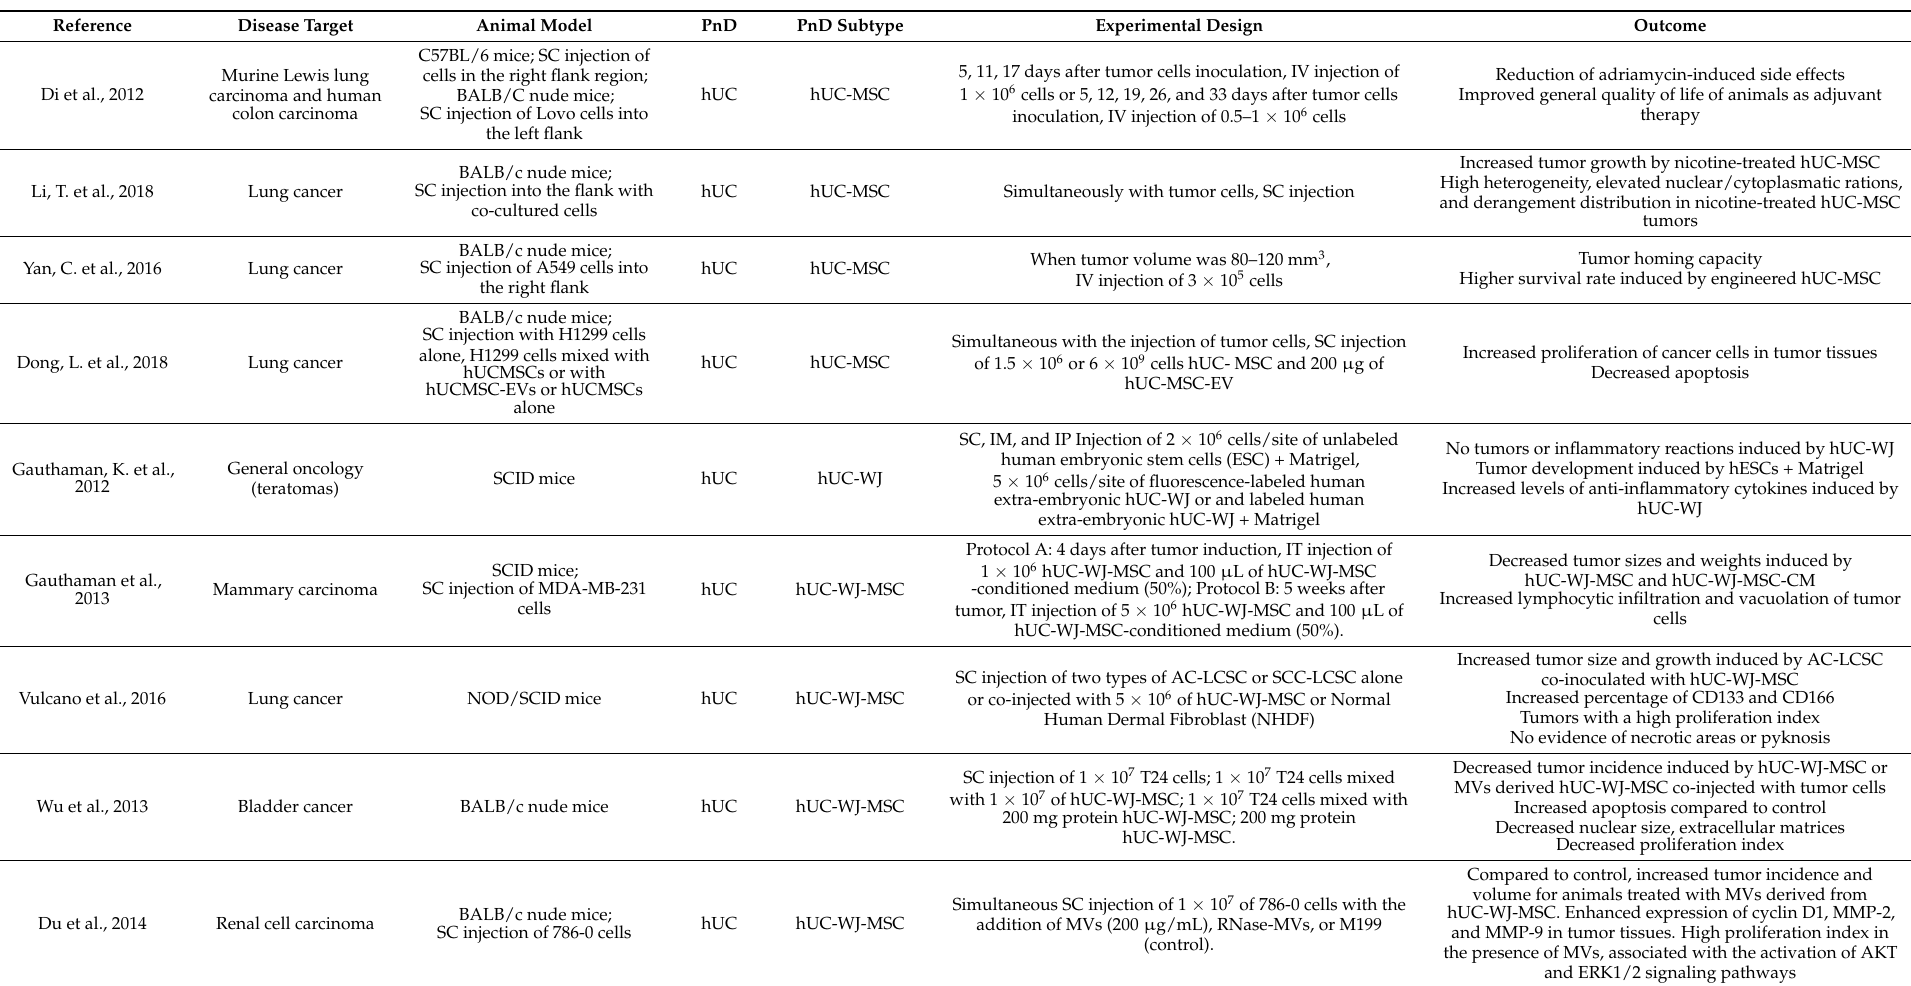
Protocol A: 4 days after tumor induction, IT injection of 1 × 10 6 hUC-WJ-MSC and 100 µ L of hUC-WJ-MSC -conditioned medium (50%); Protocol B: 5 weeks after tumor, IT injection of 5 × 10 6 hUC-WJ-MSC and 100 µ L of hUC-WJ-MSC-conditioned medium